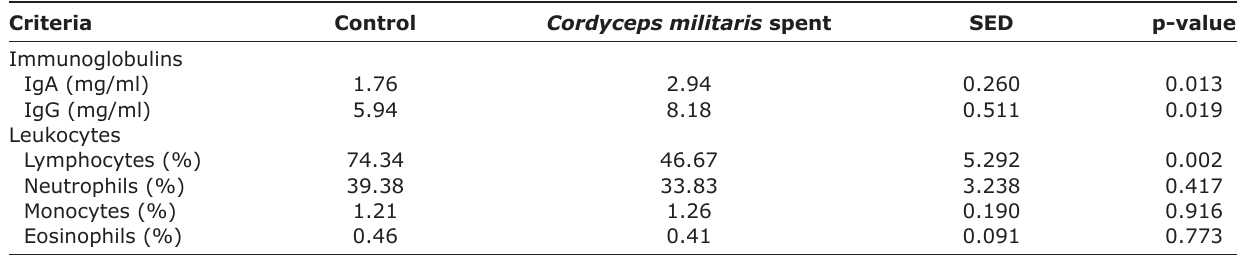
Table-4: Immunoglobulins and leukocyte percentage in growing pigs fed Cordyceps militaris spent mushroom substrate 1 .